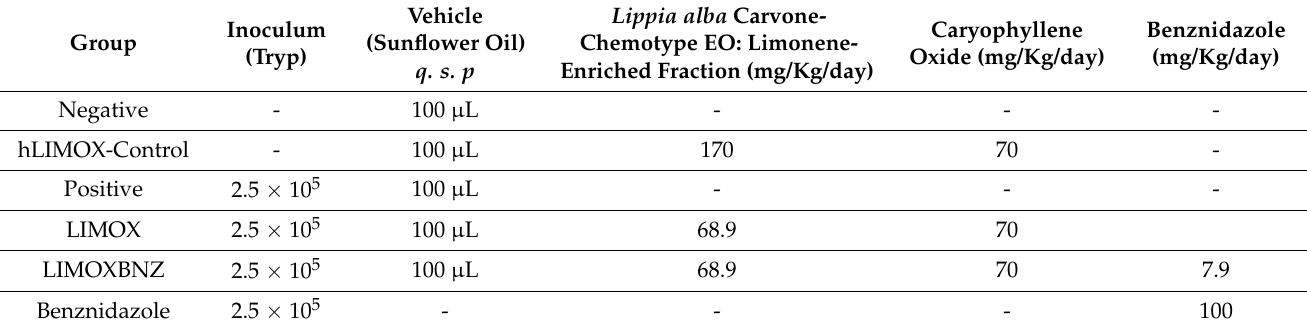
Table 1. Therapeutic schemes administrated in Trypanosoma cruzi -infected Wistar